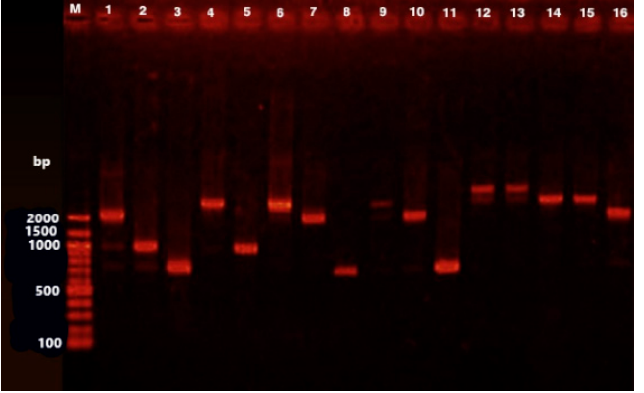
Figure 1. Electrophoresis pattern on agarose gel (1.0%) due to amplicons generated with 5’CS-3’CS primers of class I integrons. Lane M is a 100 bp ladder as a molecular size standard. Lanes 1 to 16 represent gene groups of 0.7 kbp, 1.0 kbp, 1.6 kbp, 2.0 kbp, and 3.0 kbp amplicons of